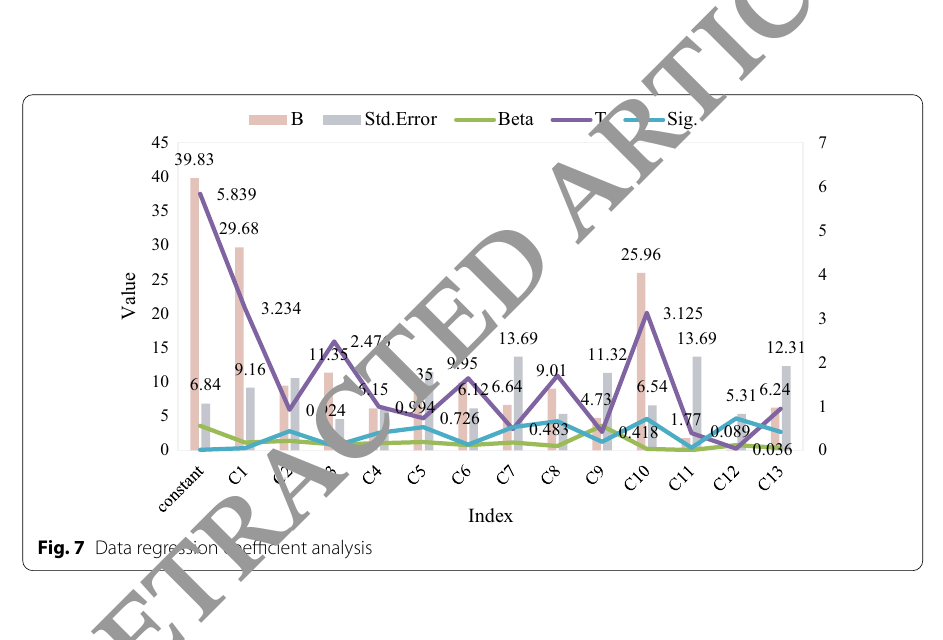
Fig. 7 Data regression coefficient